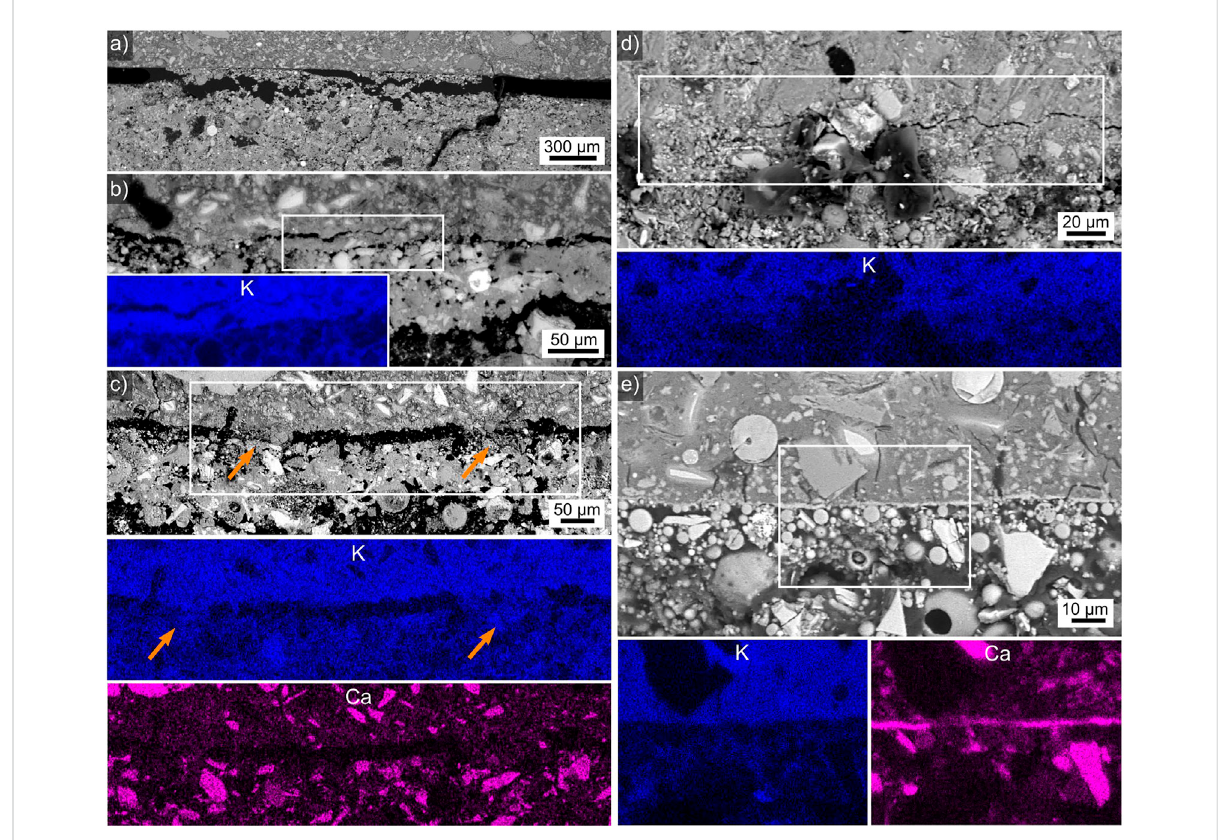
FIGURE 7 (A) SEM micrograph of a largely separated batch 4/HDGP interface. (B) A cracked batch 4/HDGP interface, an EDXS map of K acquired in the framed area is presented in the inset. (C) A batch 4/HDGP interface where two bridges between the materials are highlighted by arrows. EDXS maps of K and Ca acquired in the framed area are presented below. (D) A partially cracked batch 12/HDGP interface, an EDXS map of K acquired in the framed area is presented below. (E) An interface where batch 12 and the HDGP are in direct contact, EDXS maps of K and Ca acquired in the framed area are presented below. The HDGP is at the top of all fi